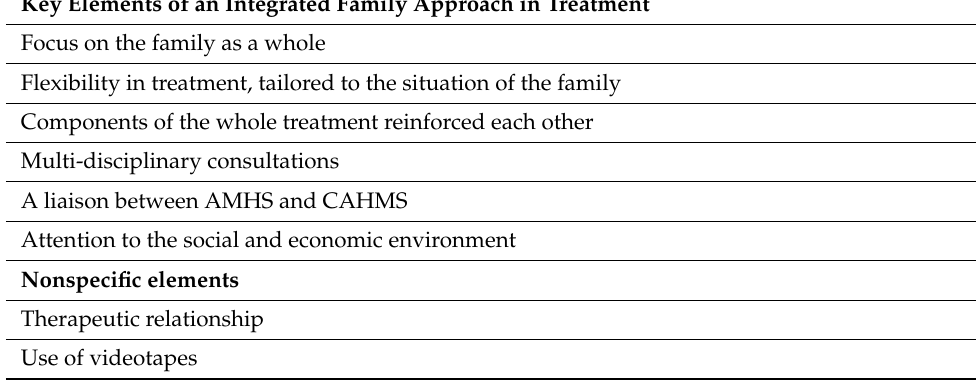
Table 5. Key elements and nonspecific elements which contributed to the success of the treatment according to